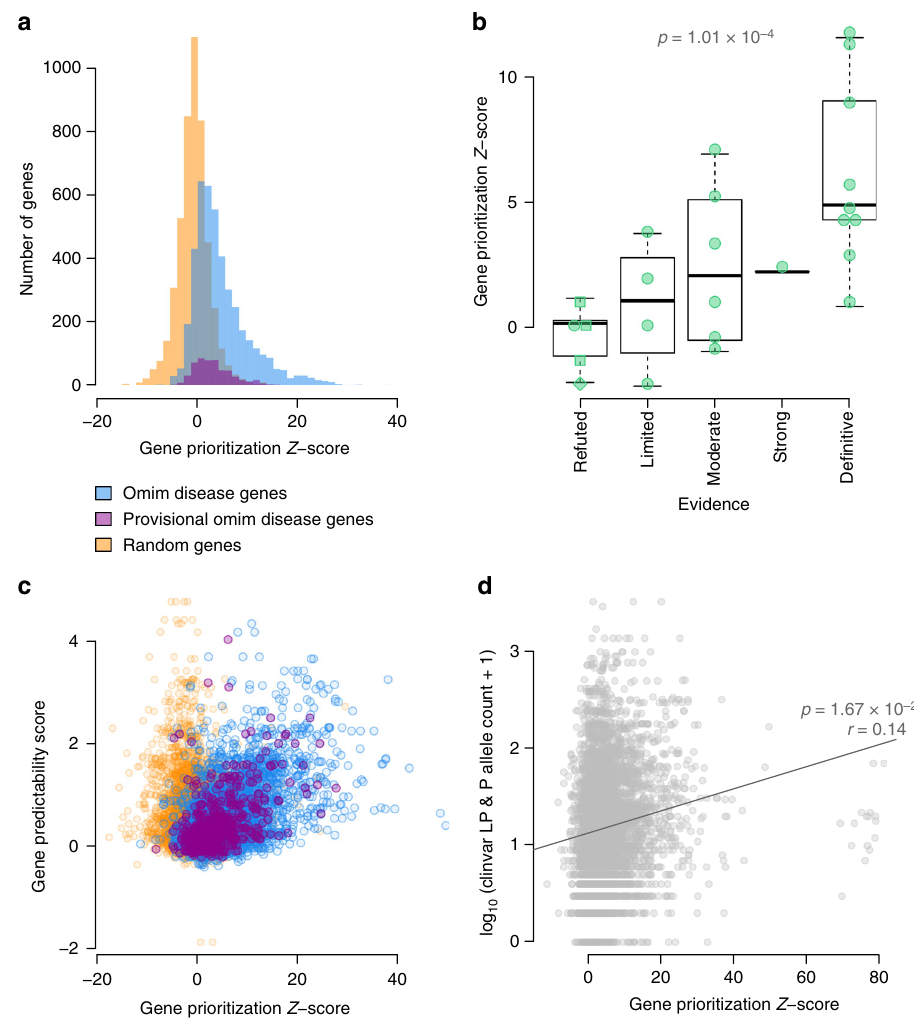
Fig. 3 Performance of disease gene prioritization compared to random permutation. a OMIM disease genes and provisional disease genes have signi fi cantly stronger prioritization Z -scores compared to permuted disease genes (T-test p-values: 2.16 × 10 − 532 and 5.38 × 10 − 80 , respectively). We also observe that the predictions of the provisional OMIM genes are, on average, weaker than the other OMIM disease genes ( T -test p -value: 1.89 × 10 − 7 ). Because we use a leave-one-out strategy when calculating prioritization Z -scores for genes that have already been associated to an HPO term, there is no prediction bias towards known associations. Therefore, this benchmark is informative of the power to predict novel associations (see methods). b We observe a signi fi cant relation (Spearman p -value: 1.01 × 10 − 4 ) between the burden of evidence that a gene is associated to a disease and the GADO prioritization Z -score. Most genes are scored by 13 some additional refuted genes, denotated as squares or diamonds, are reported by ref. 8 and ref. 12 c We observe a clear relation between the prioritization Z -scores and the gene predictability scores (Pearson r = 0.54). We do not observe this relation in the permuted results. d Our gene prioritization Z -scores are signi fi cantly correlated (Pearson p -value: 1.67 × 10 − 23 ) to the number of likely pathogenic (LP)